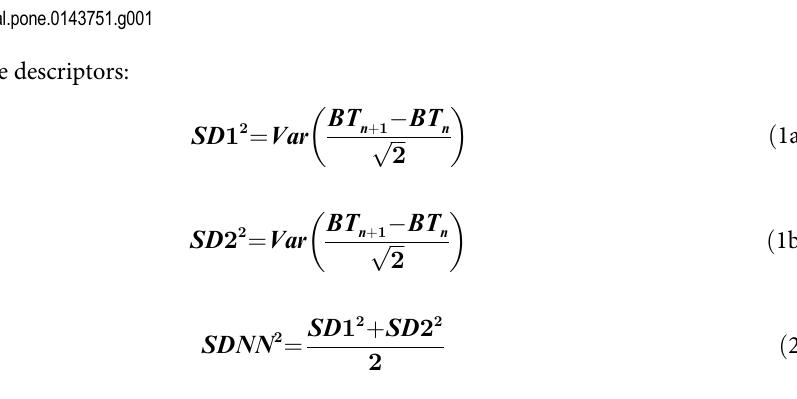
Fig 1. A sample Poincaré plot analysis of temperature time series derived from a 12-h recording during dark phase from a control rat. The dashed line is the identity line; all points on this line correspond to two neighboring temperatures with equal values; all points above this line correspond to BT increases (BT n > BT +1 n ); all points below this line correspond to BT reductions (BT n+1 +1 : BT of the next value. SD1: the standard deviation quantifying the dispersion of points in the Poincaré plot across the identity line. SD2 represents the dispersion along the identity